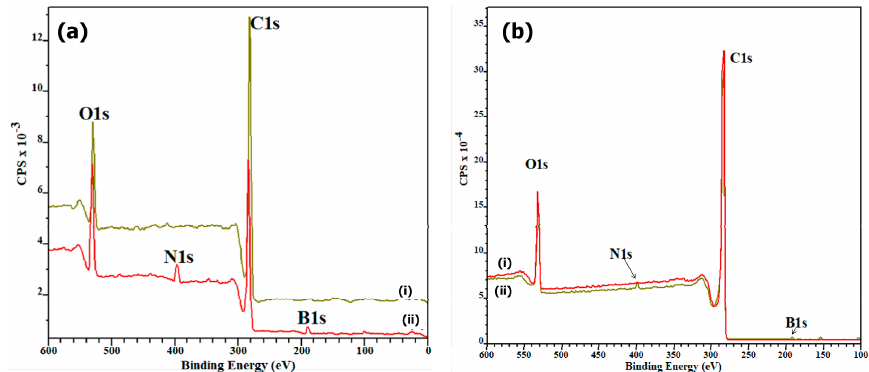
Figure 3. XPS survey spectra of ( a ) pristine CSs ( i ) and BN-CSs ( ii ); and ( b ) activated CSs ( i ) and activated BN-CSs ( ii ), respectively.